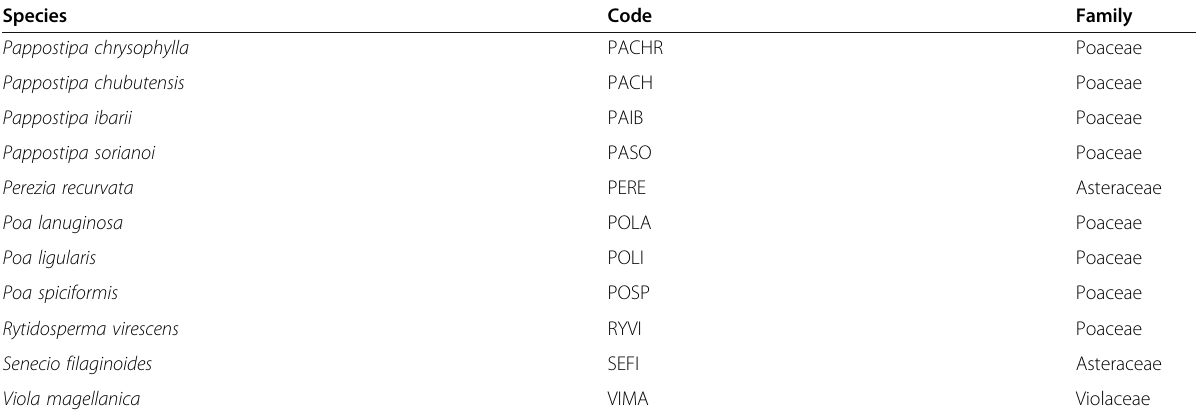
Table 2 Codes and taxonomy of the vascular plant species selected for the modelling of potential habitat suitability in Santa Cruz Province (Continued)